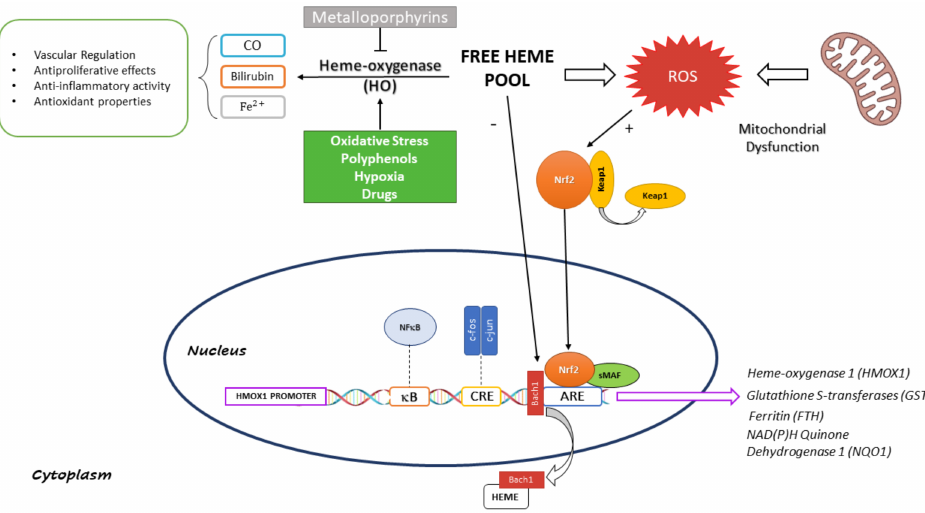
Figure 1. Schematic Representation of Heme-Oxygenase 1 Transcriptional Regulation and